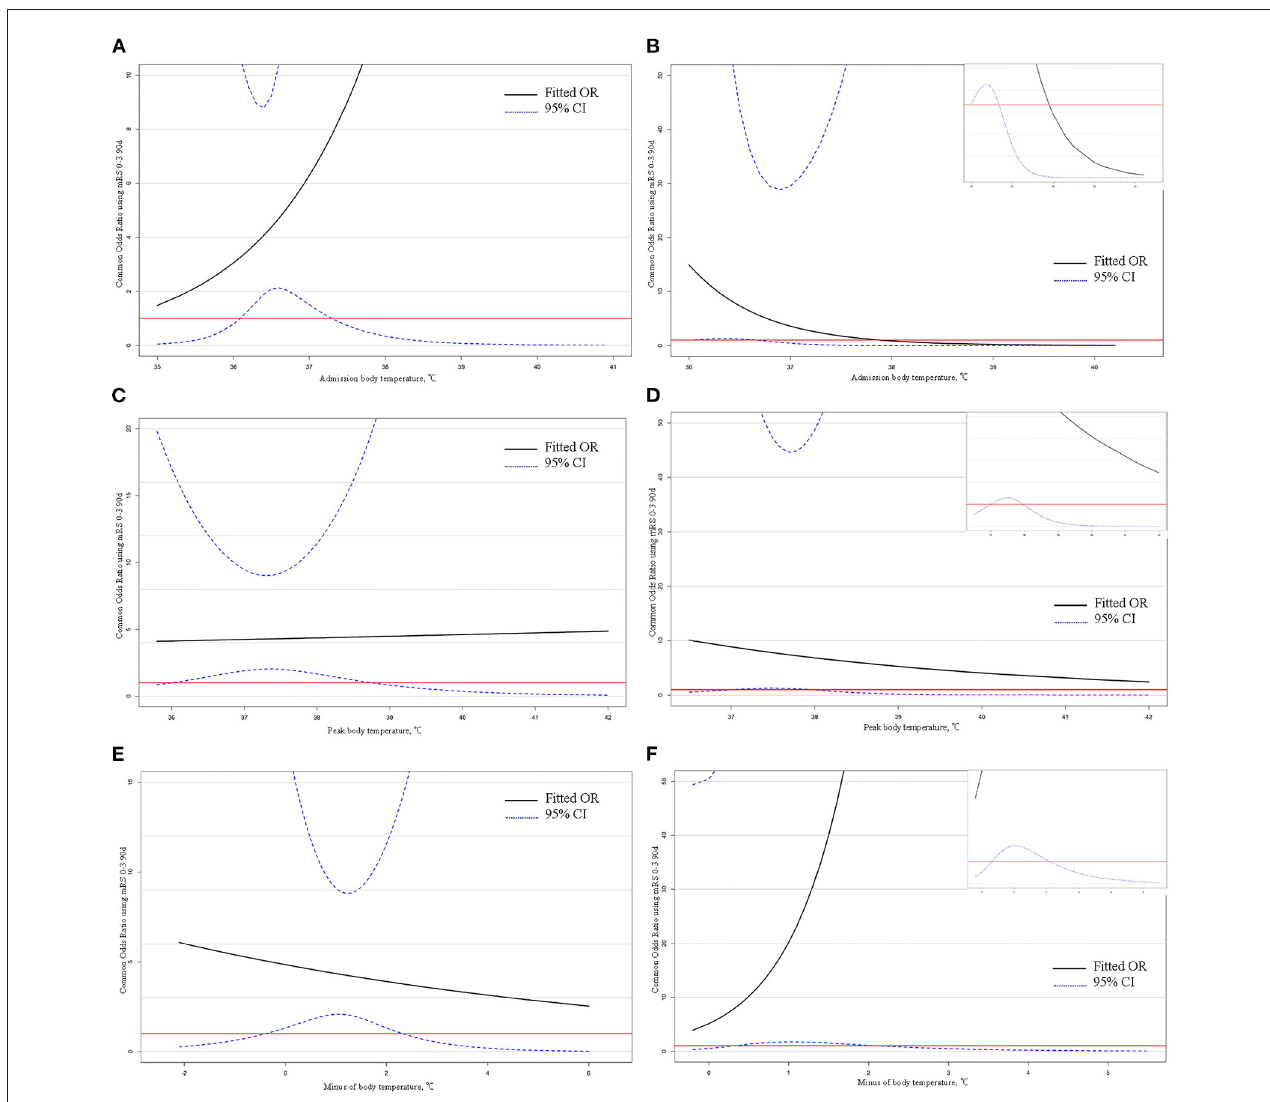
FIGURE 2 | Odds ratio mRS 0–3 90 days in recanalization vs. non-recanalization and intravenous thrombolysis vs. no intravenous thrombolysis by body temperature in subgroup. (A,C,E) Odds ratio mRS 0–3 90 days in recanalization vs. non-recanalization by admission body temperature, peak body temperature, and minus body temperature. In all images, the threshold indicates the intersection of the lower limit of the confidence interval with the red line, and the part above the threshold indicates that the benefit of the recanalization group is clearly greater than that of the non-recanalization. (B,D,F) Odds ratio mRS 0–3 90 days in intravenous thrombolysis vs. no intravenous thrombolysis by admission body temperature, peak body temperature, and minus body temperature. The upper right corner of the images indicates a partial zoom. In all images, the threshold indicates the intersection of the lower limit of the confidence interval with the red line, and the part above the threshold indicates that the benefit of the intravenous thrombolysis group is clearly greater than that of the no intravenous thrombolysis.